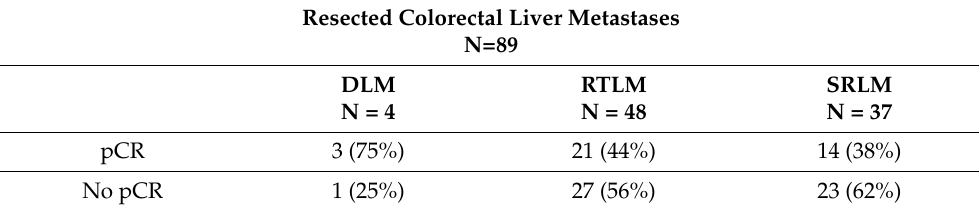
Table 2. pCR rate of resected colorectal liver metastases. Resected Colorectal Liver Metastases